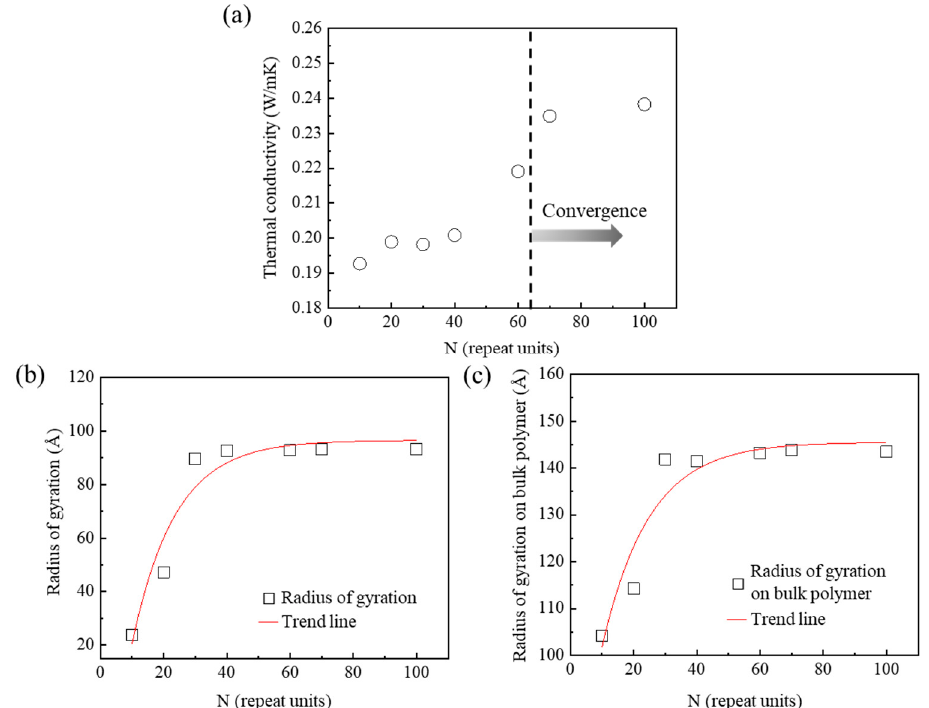
Figure 3. Thermal transport according to the length of the amorphous chains in semi-crystalline PEEK: ( a ) thermal conductivities, ( b ) radius of gyration, and ( c ) radius of gyration on the bulk pol- ymer.